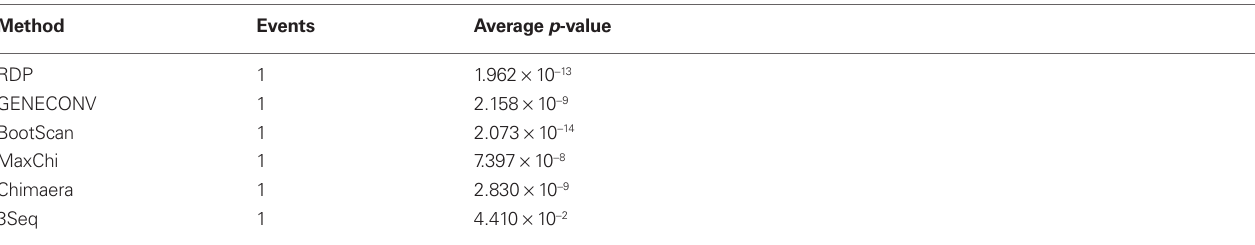
Table 2 | Average p -value from different methods in RDP3 (Martin et al., 2005b) inferring the recombination event between ToLCMaB-[iN;Pun;04] and ToLCB-[PK;rYK;97] at position of